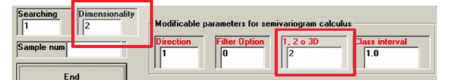
Figure 14: “Dimensionality” and “1, 2, or 3D” control panels.